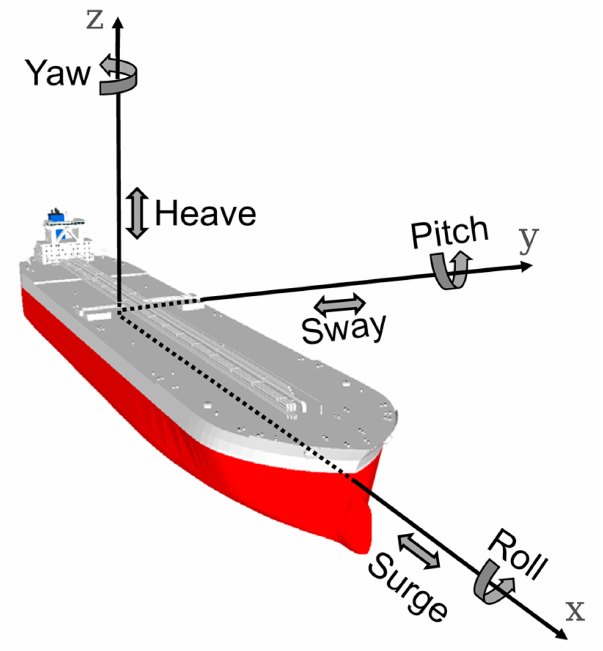
Figure 5. Vessel six degrees of freedom (after